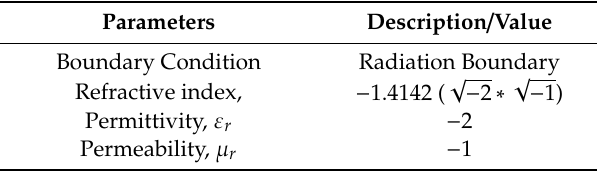
Table 6. Simulation parameters using High Frequency Structure Simulator (HFSS).